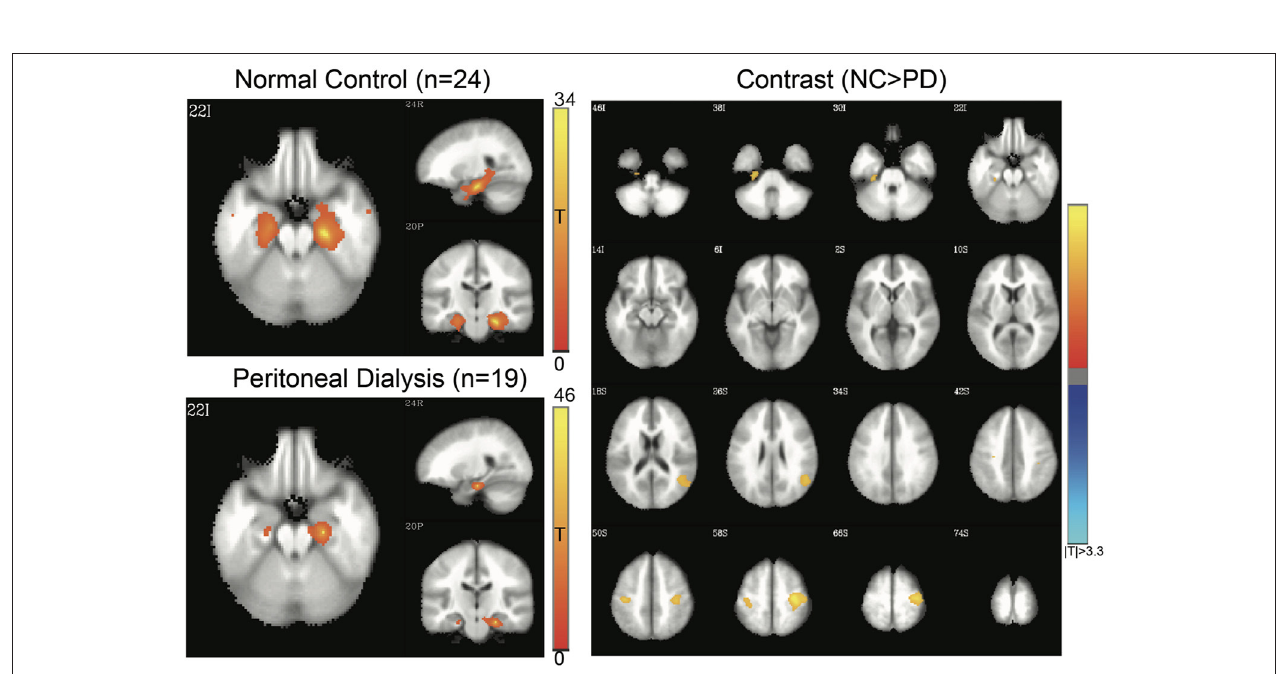
FIGURE 5 | Hippocampal network (HN) of controls and patients with PD. Connectivity map of either group is shown at the left side (FWE-corrected p < 0.05), and contrast map at the right side (3dClustSim-corrected p < 0.05). In the contrast map, the orange color represents significantly increased connectivity in controls, whereas the blue color represents decreased connectivity in controls. PD, peritoneal dialysis; NC, normal controls.